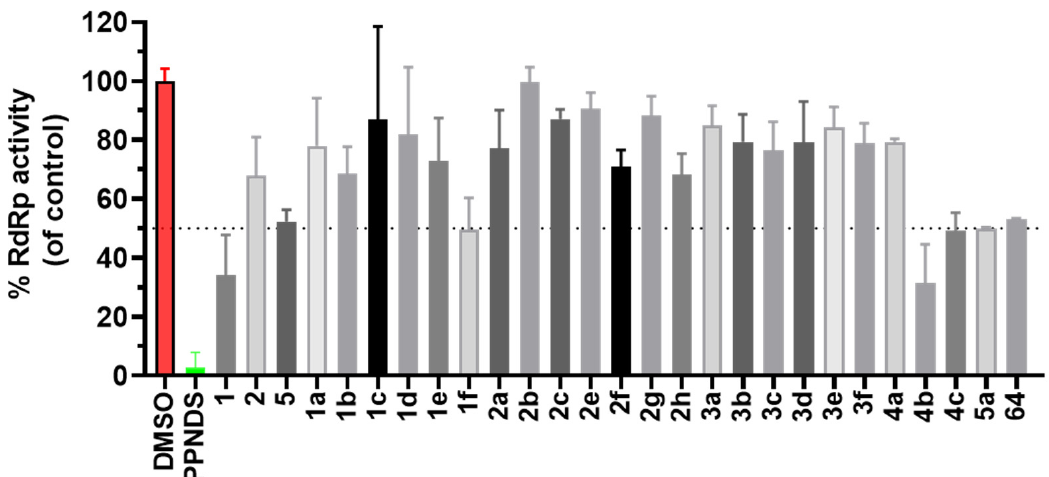
Figure 10. Inhibitory effect of the test compounds on the human norovirus RdRp activity. Compounds were tested at 20 µM. Percentage of inhibition was normalized to control DMSO (red bar). PPNDS (green bar) was used as positive control, along with parent compounds 1, 2 and 5 . The mean values of triplicate datasets with standard error of the mean are shown.